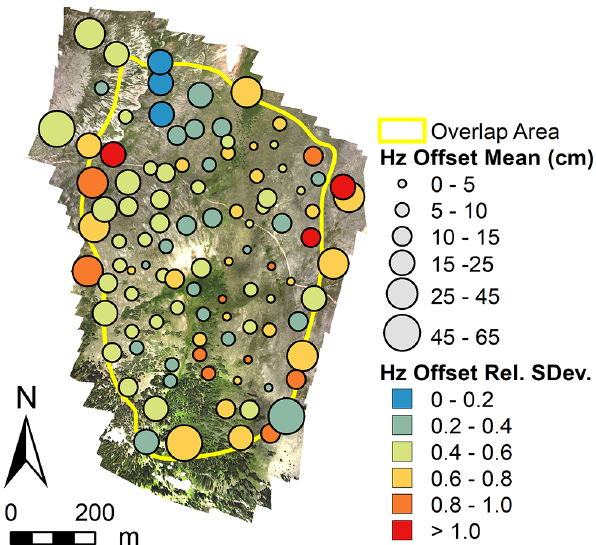
Figure 8. Spatial distribution of horizontal (Hz) offset errors com- pared to the 14 August position.